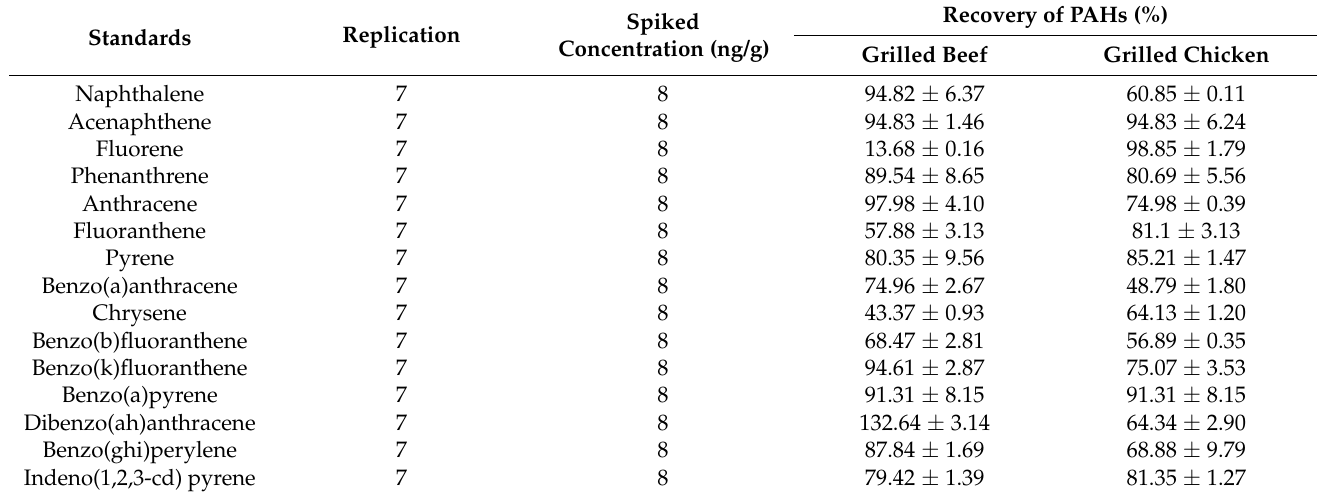
Table 3. Recoveries of PAHs spiked in grilled beef and chicken meat